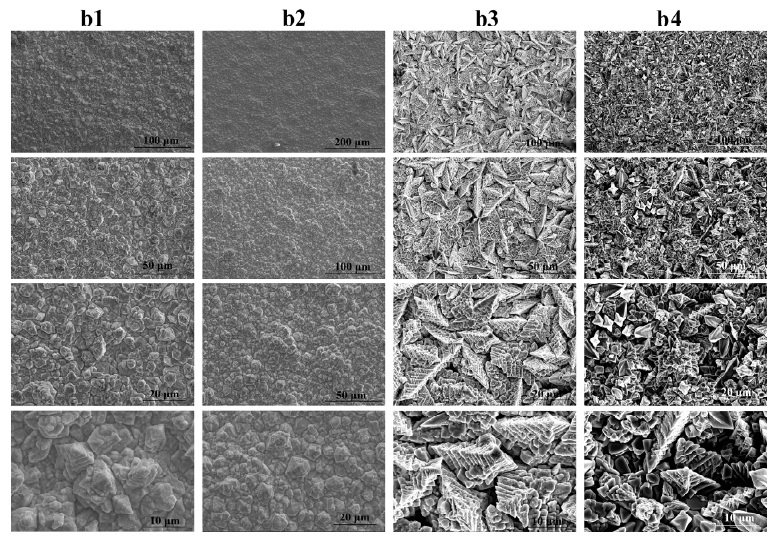
Figure 9. SEM images of copper surface under different reverse pulse duty cycle. ( b1 ) is 20%;( b2 ) is 40%;( b3 ) is 60%;( b4 ) is 80%;